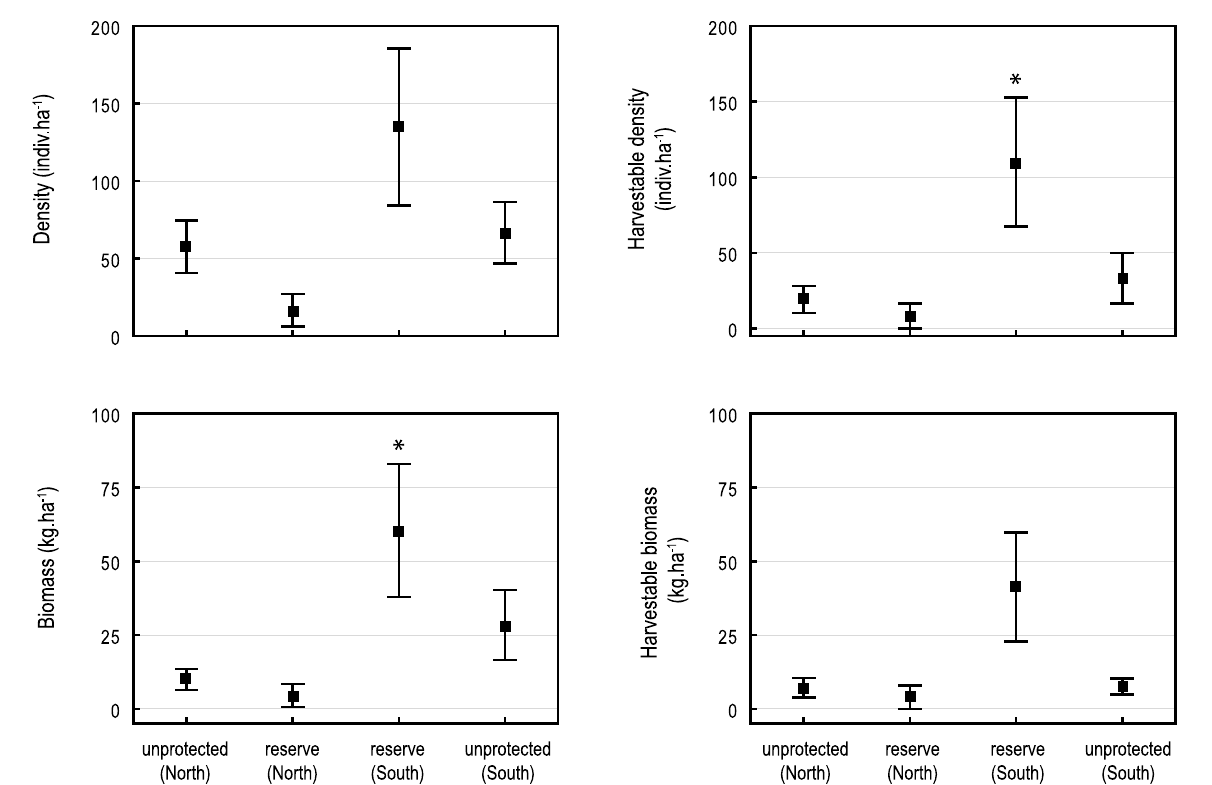
Fig 4. Comparison of trochus populations within and outside the Takara reserve. Total and legal-sized fraction of density and biomass (mean ± SE). Results of Kruskal-Wallis tests: * p < 0.05.